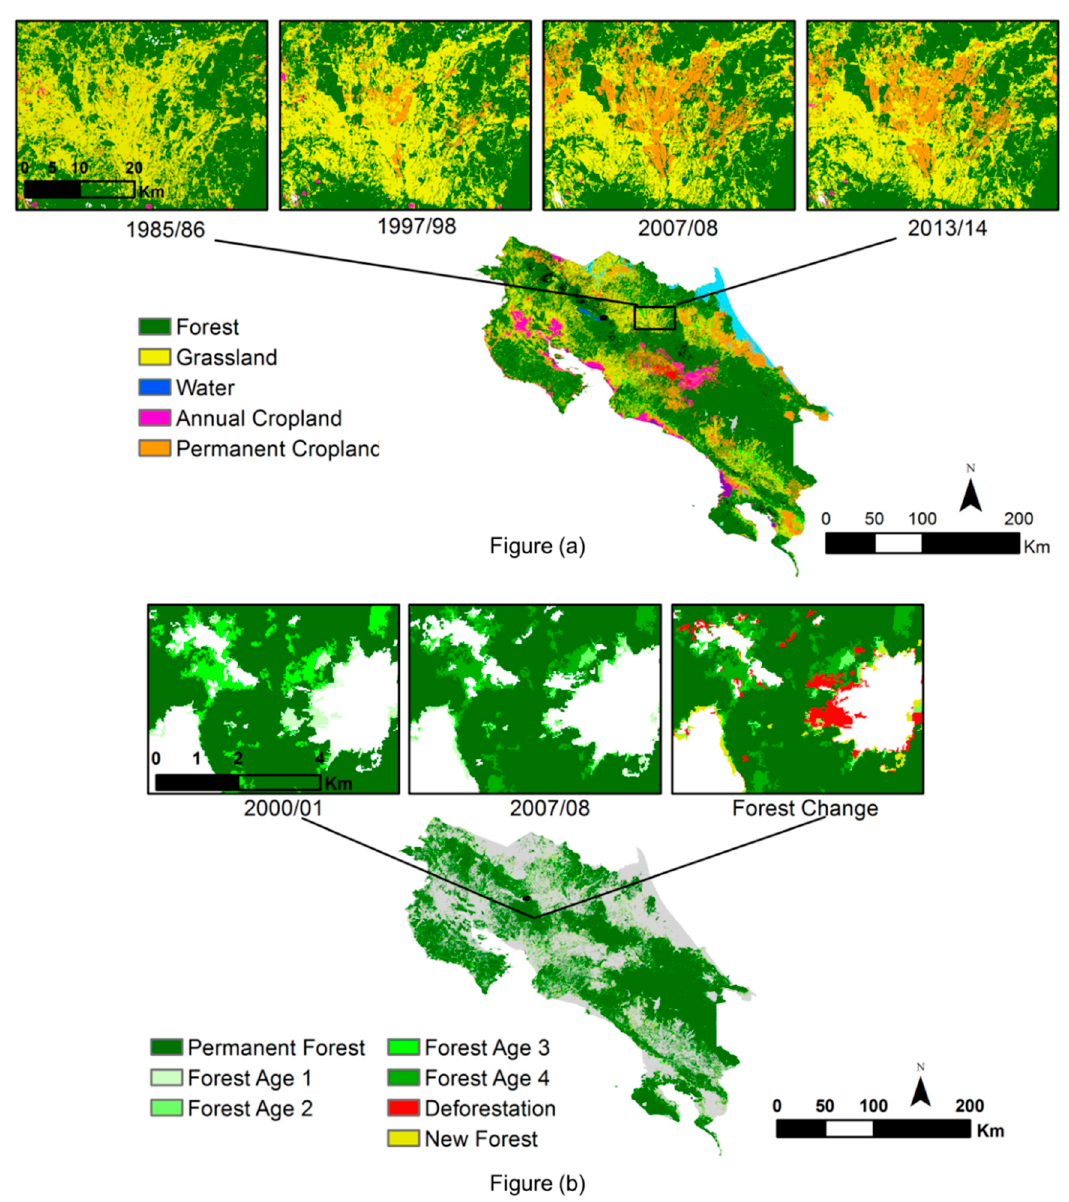
Figure 5. Illustration of land cover change dynamics in sample areas in Costa Rica: ( a ) Permanent cropland expansion from 1986 to 2013; ( b ) Forest age class distribution and deforestation patterns over different forest age classes.